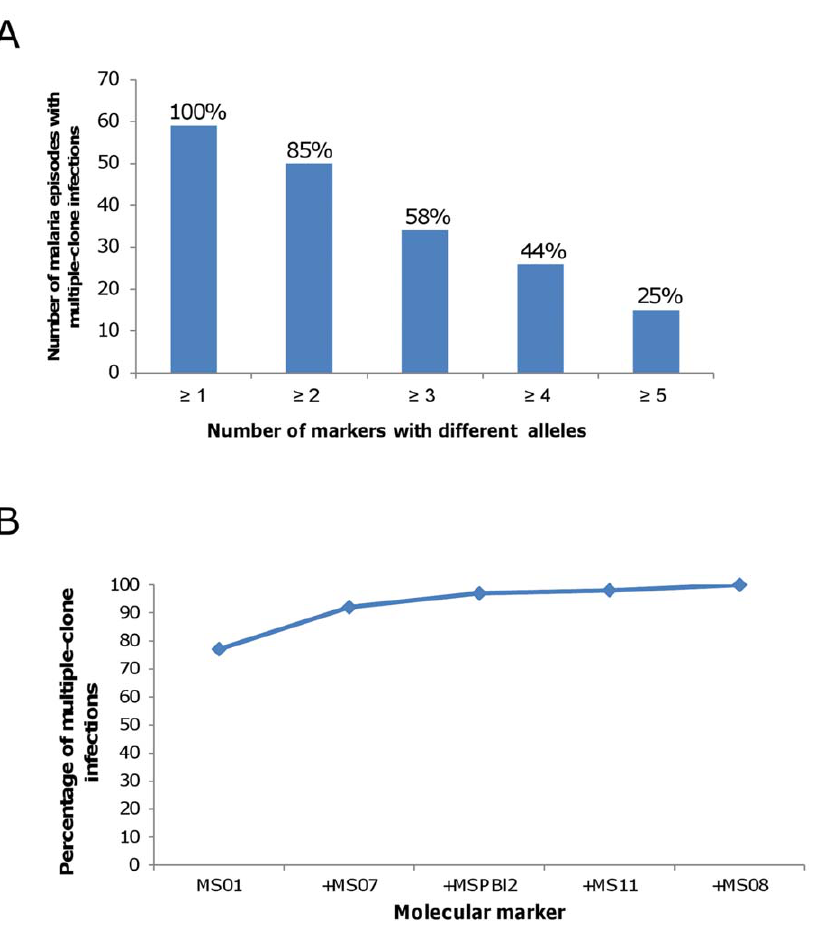
Figure 4. Detection of multiple-clone P.vivax infections using a panel of 10 markers. (A) Number and percent of malaria episodes showing multiple-clone infections detected by different numbers of markers. (B) Minimum number of markers able to detect all multiple clone infections was five: MS01 (77%), MS01 + MS07 (92%), MS01 + MS07 + MSPBl2 (97%), MS01 + MS07 + MSPBl2 + MS11 (98%), MS01 + MS07 + MSPBl2 + MS11 + MS08 (100%).